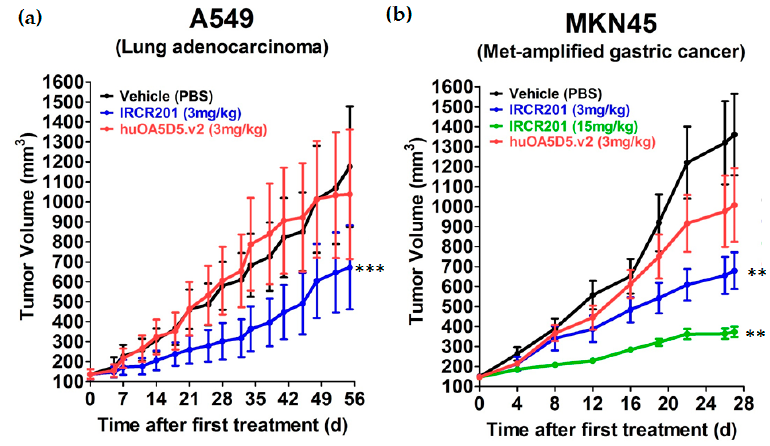
Figure 8. In vivo potency of IRCR201 in c-Met-expressing tumor xenograft models. ( a ) IRCR201 was dosed intravenously twice a week at 3 mg/kg in an A549 non-small cell lung cancer (NSCLC) xenograft model, as compared with the PBS-treated group or huOA5D5.v2-treated group; ( b ) IRCR201 was intravenously injected at 3 or 15 mg/kg twice a week in an MKN45 gastric cancer xenograft model compared with the PBS-treated group or huOA5D5.v2-treated group. Six mice per group were used for the A549 and MKN45 studies. Asterisks (*) indicate p -values versus PBS-treated group (vehicle group) according to one-tailed two-sample t -test. p -Value < 0.05 was considered statistically significant. (** p < 0.01, *** p < 0.001).